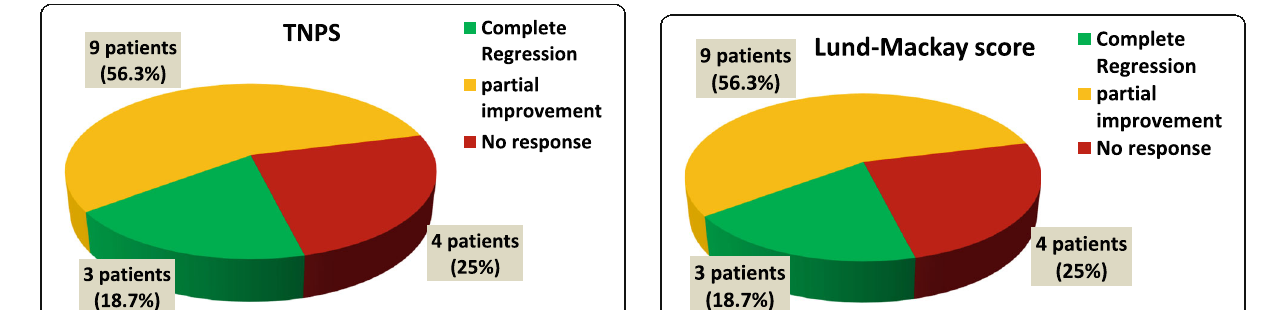
Fig. 4 Pie chart showing the effect of oral steroids on Lund-Mackay